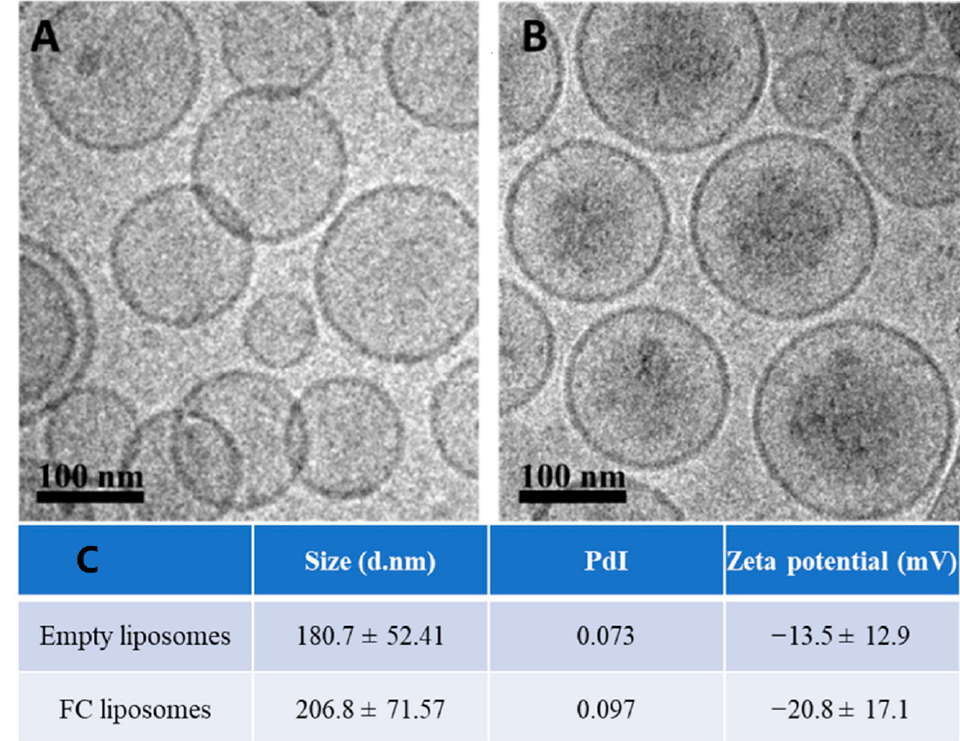
Figure 2. Characterization of liposomes encapsulating FC. Cryo − TEM images of ( A ) empty liposomes and ( B ) FC − liposomes (scale bar 100 nm). ( C ) Liposome size, polydispersity index (PdI), and zeta potential of empty liposomes and liposomes with FC.